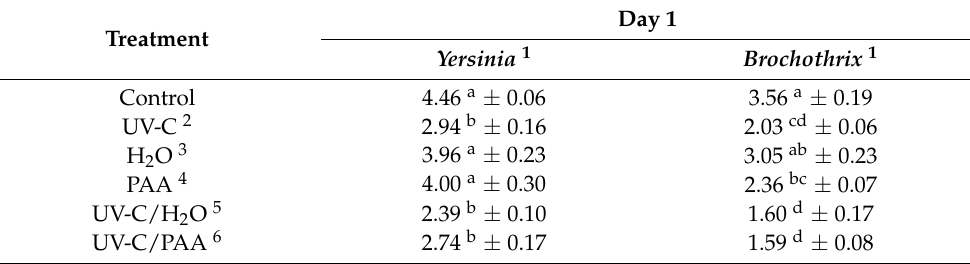
Table 4. LSM ± SE of Yersinia enterocolitica and Brochothrix thermosphacta counts on pork inoculated with lower concentrations of both bacterial species ( Y. enterocolitica 6 × 10 6 cfu/mL inoculum broth; B. thermosphacta 1 × 10 6 cfu/mL inoculum broth) after UV-C, peracetic acid (PAA), and H 2 O treatment alone and in combinations ( n =